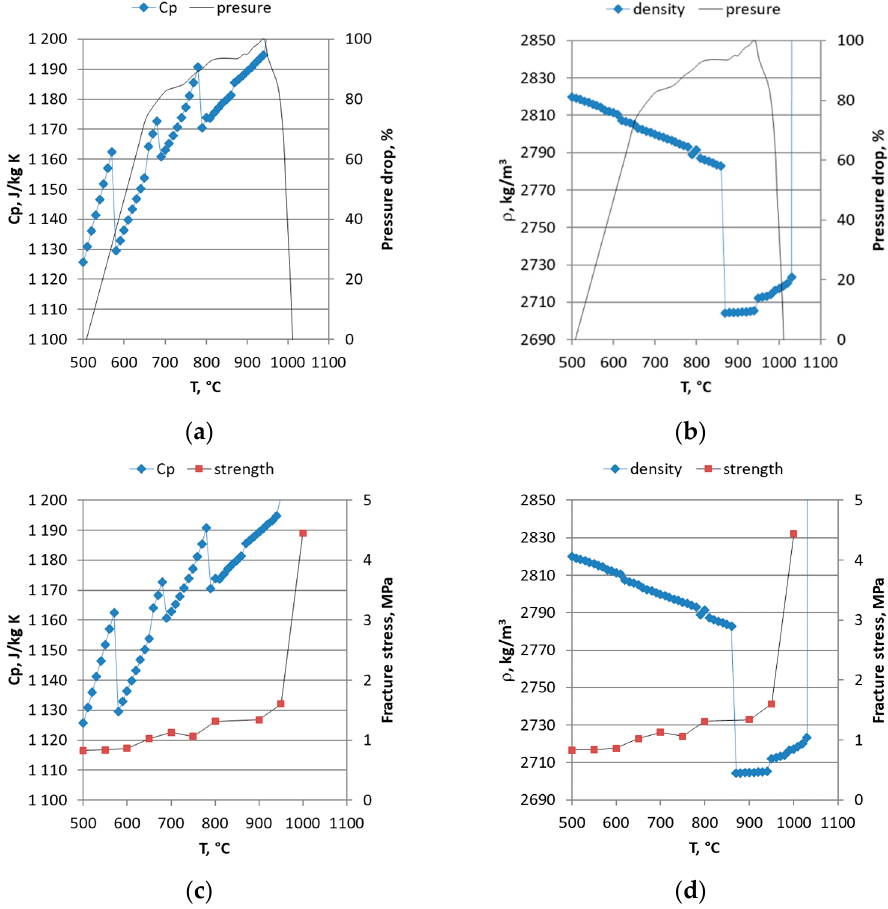
Figure 12. Bituminous coal: ( a ) Specific heat (c p ) and pressure drop as a function of temperature; ( b ) density ( ρ ) and pressure drop as a function of temperature; ( c ) specific heat and fracture stress as a function of temperature; ( d ) density and fracture stress as a function of temperature.